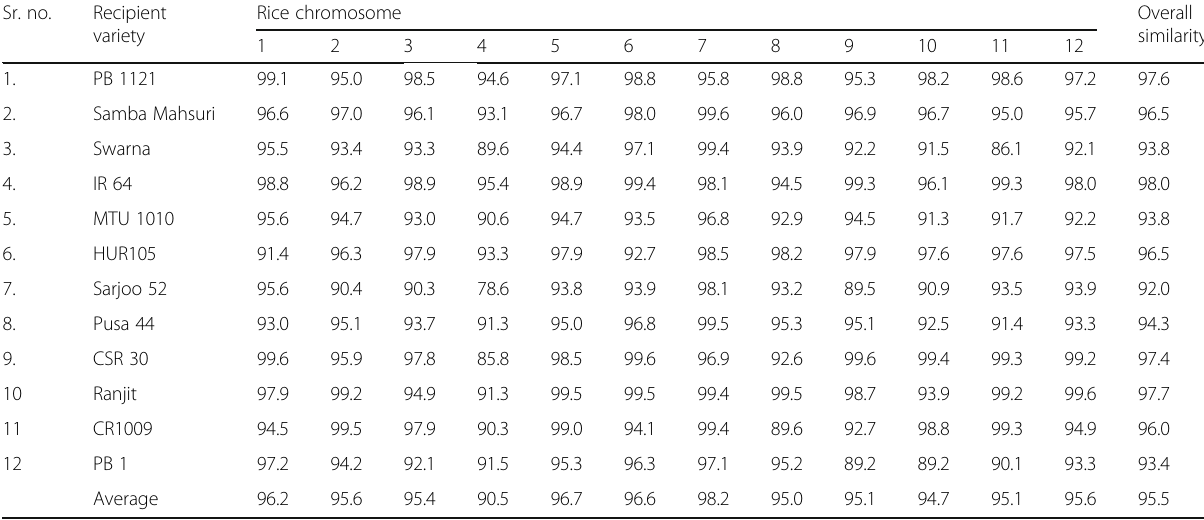
Table 2 Percentage Genome Similarity of The Best qGN4.1 QTL-NILs With Recipient Parent at BC3F2 Generation in the Genetic Background of Twelve Different Mega Varieties of Rice Analysed Using OsSNPnks SNP Genotyping Chip Sr.